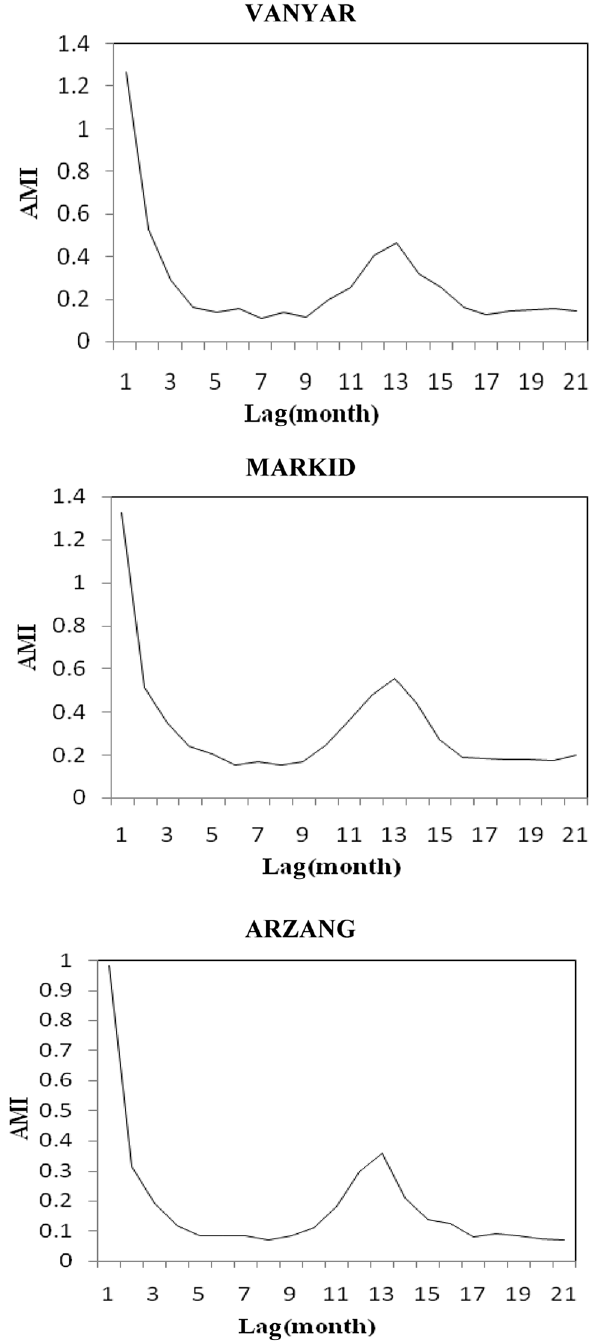
Fig. 3 Average mutual information (AMI) function of the study sta- tions time